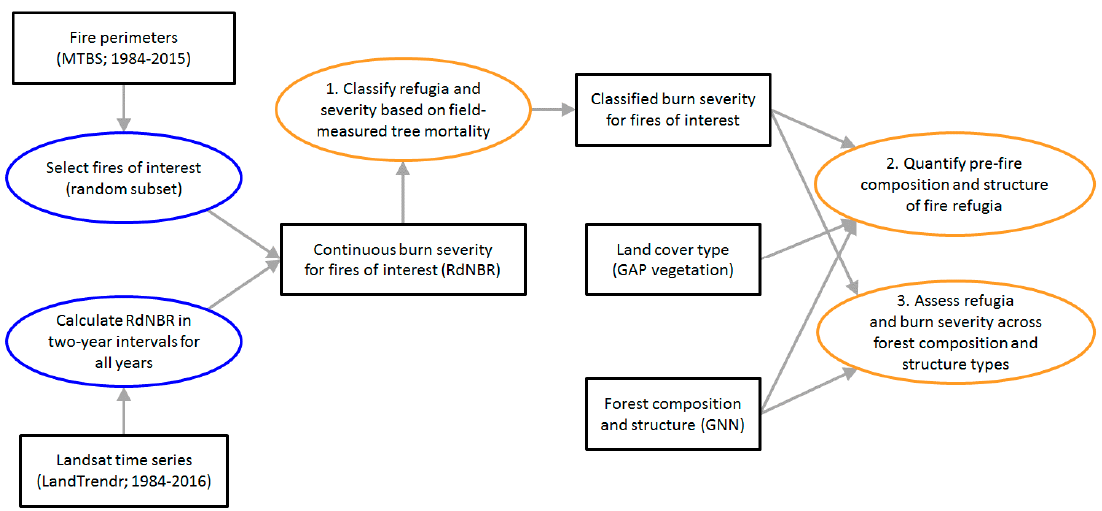
Figure 1. Overview of key spatial datasets (black), processing steps (blue), and objectives (orange). See Section 2 for fire selection criteria. Data sources and references: MTBS: https://mtbs.gov;